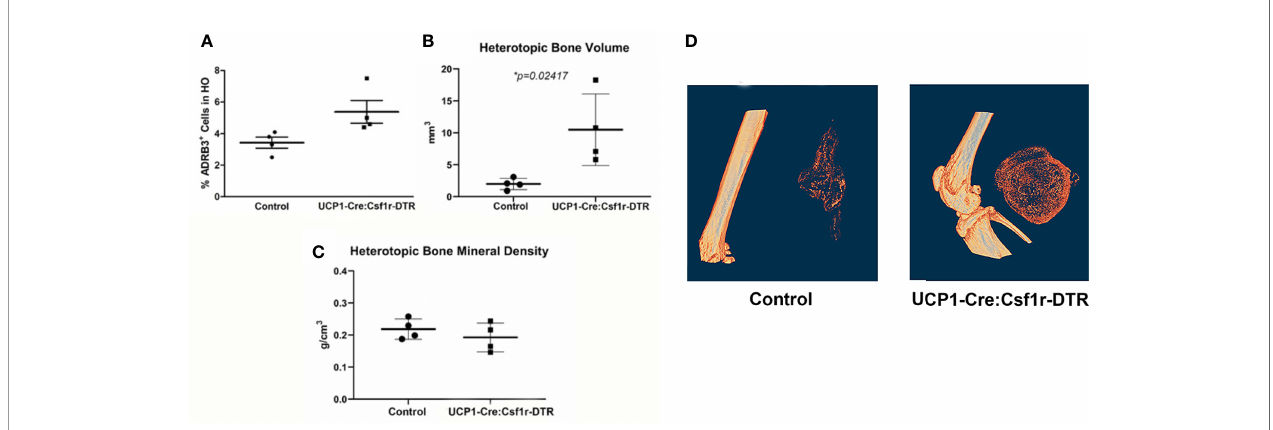
FIGURE 7 | The amount of heterotopic bone increases upon speci fi c destruction of ADR b 3+ macrophages. Ucp1-Cre : Csfr1 fl oxSTOP fl ox DTRmcherry mice were injected with Dta and with AdBmp2-transduced cells on day 0. On day 4 the mice were euthanized and the amount of Ucp1+ cells in heterotopic bone was determined as well as the bone volume and bone mineral density. Panel (A) shows the percentage of Adrb3+ cells present in the control compared to the percentage of Adrb3+ cells present in Ucp1-Cre:Csf1r-DTR, (B) shows the heterotopic bone volume in mm3 mice present in the Control as compared to that present in the Ucp1-Cre:Csf1r-DTR mice, and (C) shows the heterotopic bone mineral density in Control mice versus Ucp1-Cre:Csf1r-DTR. (D) shows the actual slices of the amount of bone in mice injected with Bmp2 versus Dta-treated mice injected with